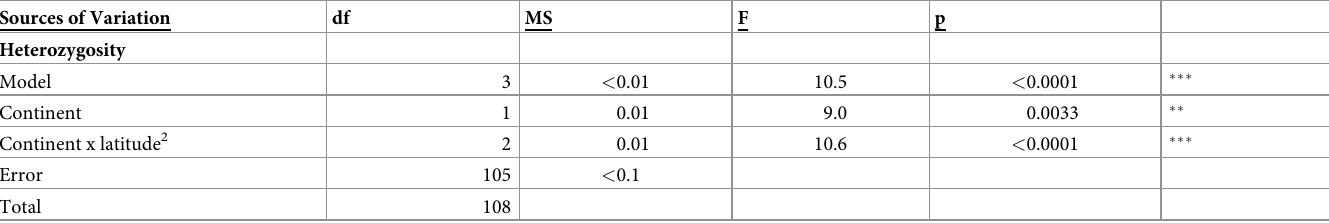
Table 4. ANOVA table of the effect of sources of variation on individual heterozygosity of Lythrum salicaria in Eurasia versus North America. Sources of Variation